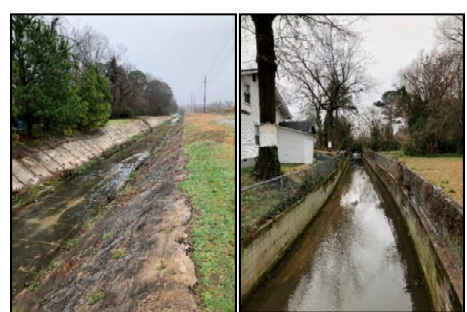
Figure 1. Big Ditch in Goldsboro, NC.